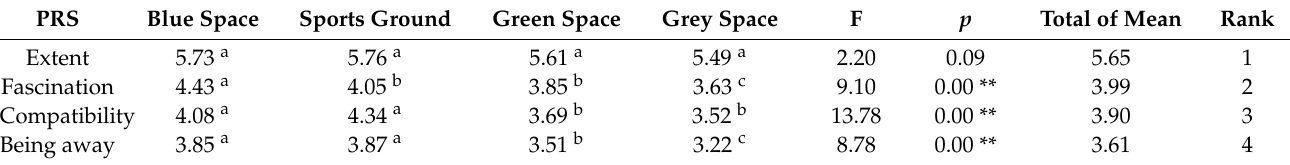
Table 5. ANOVA results among the four dimensions comparison of different environments. PRS